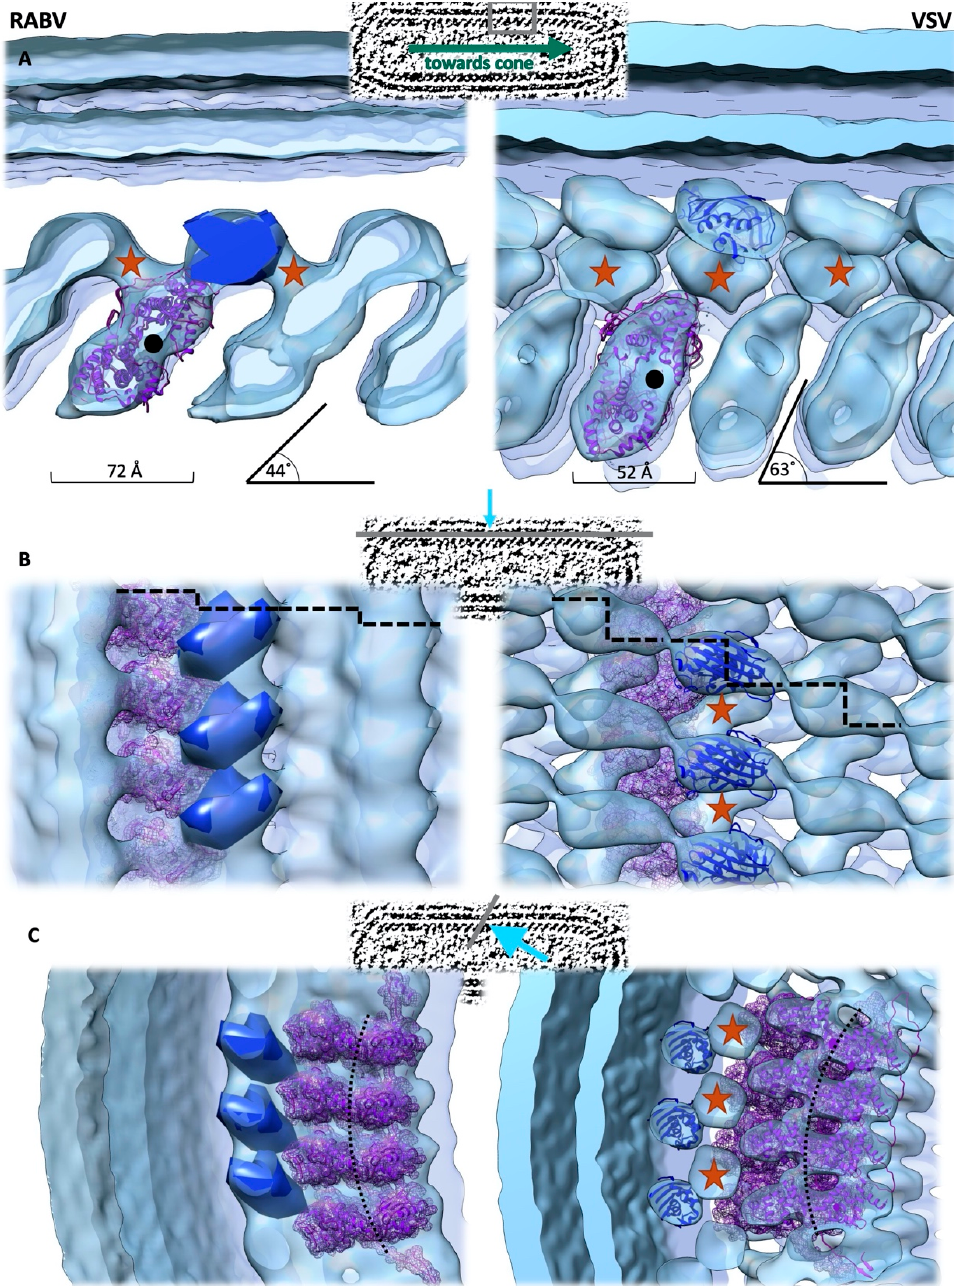
Figure 4. Comparison of the electron density maps of the RNP of RABV (EMD-4995) and VSV (EMD-1663). The viewing direction is indicated above each panel, where: ( A ) a view from the side, ( B ) a view from the membrane and ( C ) a view towards the RNA binding groove. The distance between the helical turns, as well as the deviation of the helical turns from the central axis of the virion, are indicated. The location of the genome is indicated by a black dot or a black dotted line. The N-protein structures (pdb 2gtt (RABV), 2gic (VSV)) are docked in the corresponding densities and shown in purple. The VSV M-protein structures (2w2r, blue) are docked in the orientation, as proposed by [4], whilst the location, but not the orientation, of the RABV M-protein C-terminal domain is depicted as a blue density. The proposed location of the M-protein N-terminus is indicated by red stars. Dashed lines in the middle panel indicate the step to the corresponding M-protein on the next helical turn.